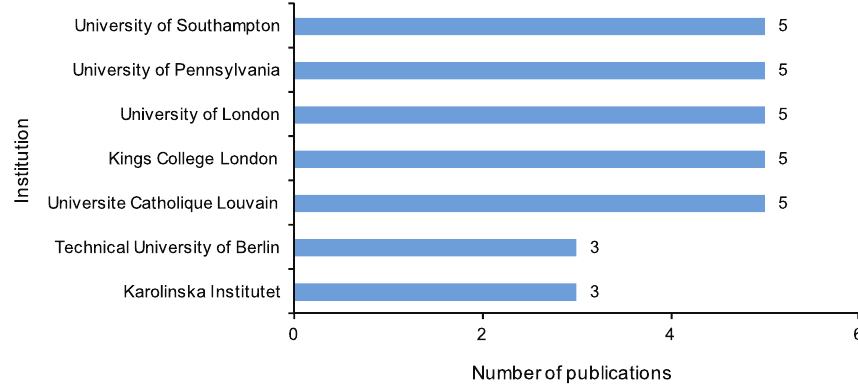
Figure 4: Information of participating institutions which contributed to Research Frontier 2.